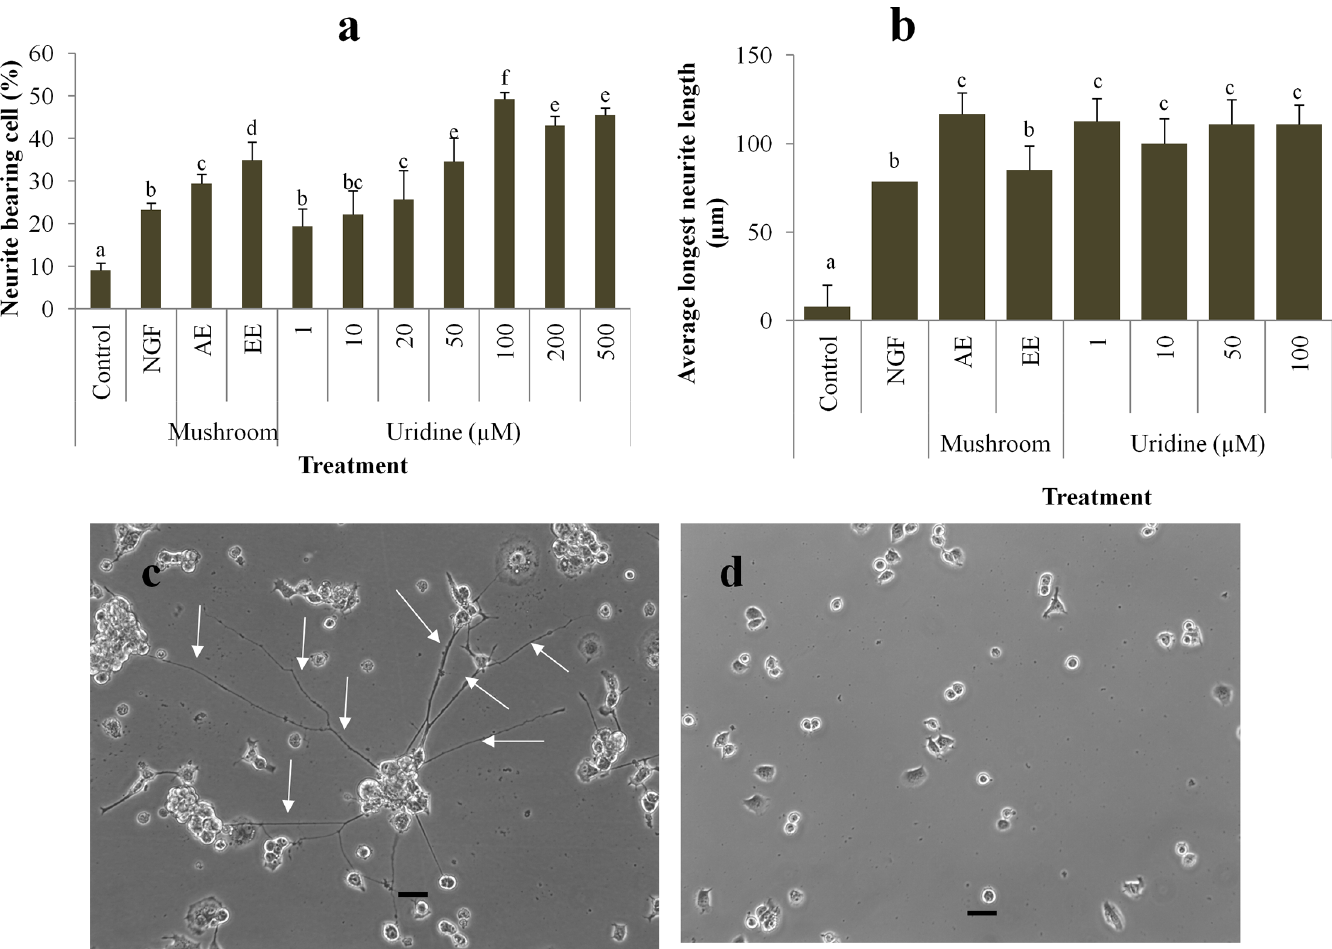
Fig 4. (a) The effects of different concentrations of uridine (1 – 500 μ M) on neurite outgrowth in differentiating N2a cells. NGF (50 ng/mL) was used as positive control and medium only (vehicle) with no treatment was used as control. Aqueous and ethanol extracts (20 μ g/mL) were compared to uridine. (b) The mean of the longest neurite length of N2a. Values are mean ± SD from three independent experiments. Different alphabets represent significant differences between samples ( p < 0.01). Phase-contrast photomicrographs of (c) uridine (100 μ M) induced neurites as indicated by arrows and (d) negative control cells treated with only vehicle (serum-free medium). Scale bar represents 20 μ